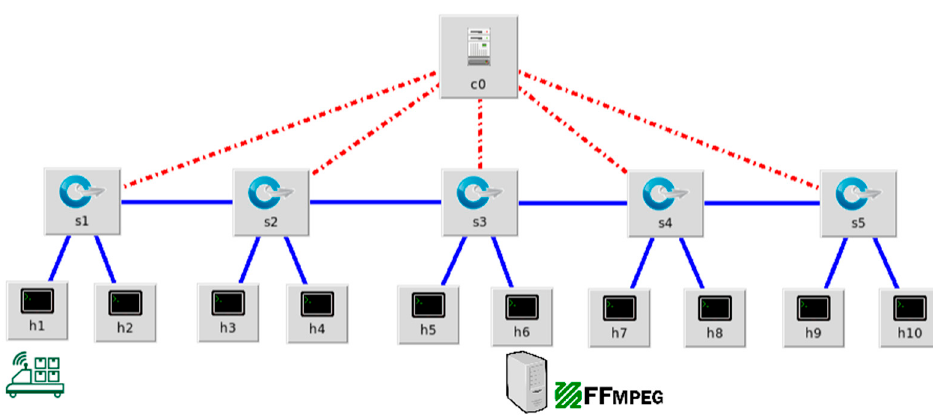
Figure 3. The SDN-enabled architecture used for simulations.